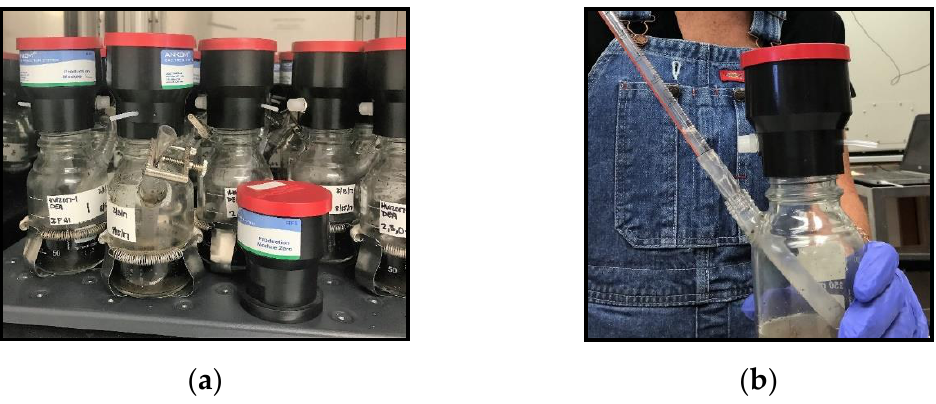
Figure 4. ( a ) Denitrifier enzyme activity (DEA) analyses on manure using an Ankom system. ( b ) Liquid samples were collected through an anaerobic sidearm port on Ankom bottles and analyzed for nitrate/nitrite disappearance over time. The Ankom Gas Production module (lid) released excess headspace gas from bottle at predetermined pressure.